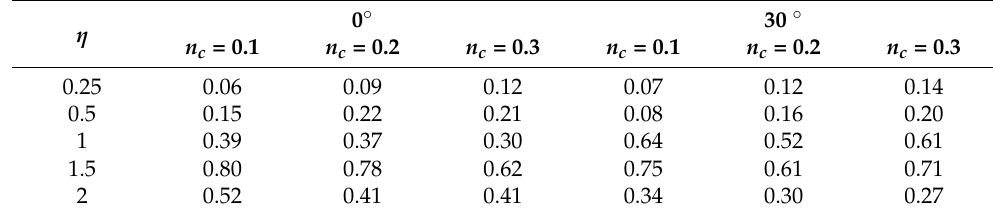
Table 4. Mean value of variation coefficient of horizontal displacement amplitude (with sediment porosity).